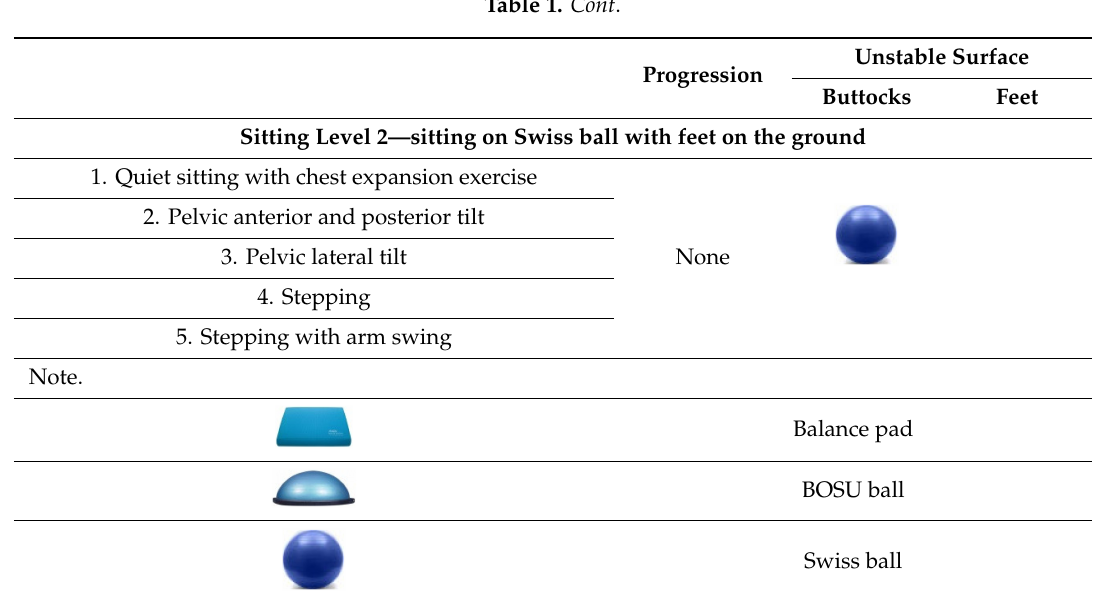
Unstable Surface Progression Buttocks Feet